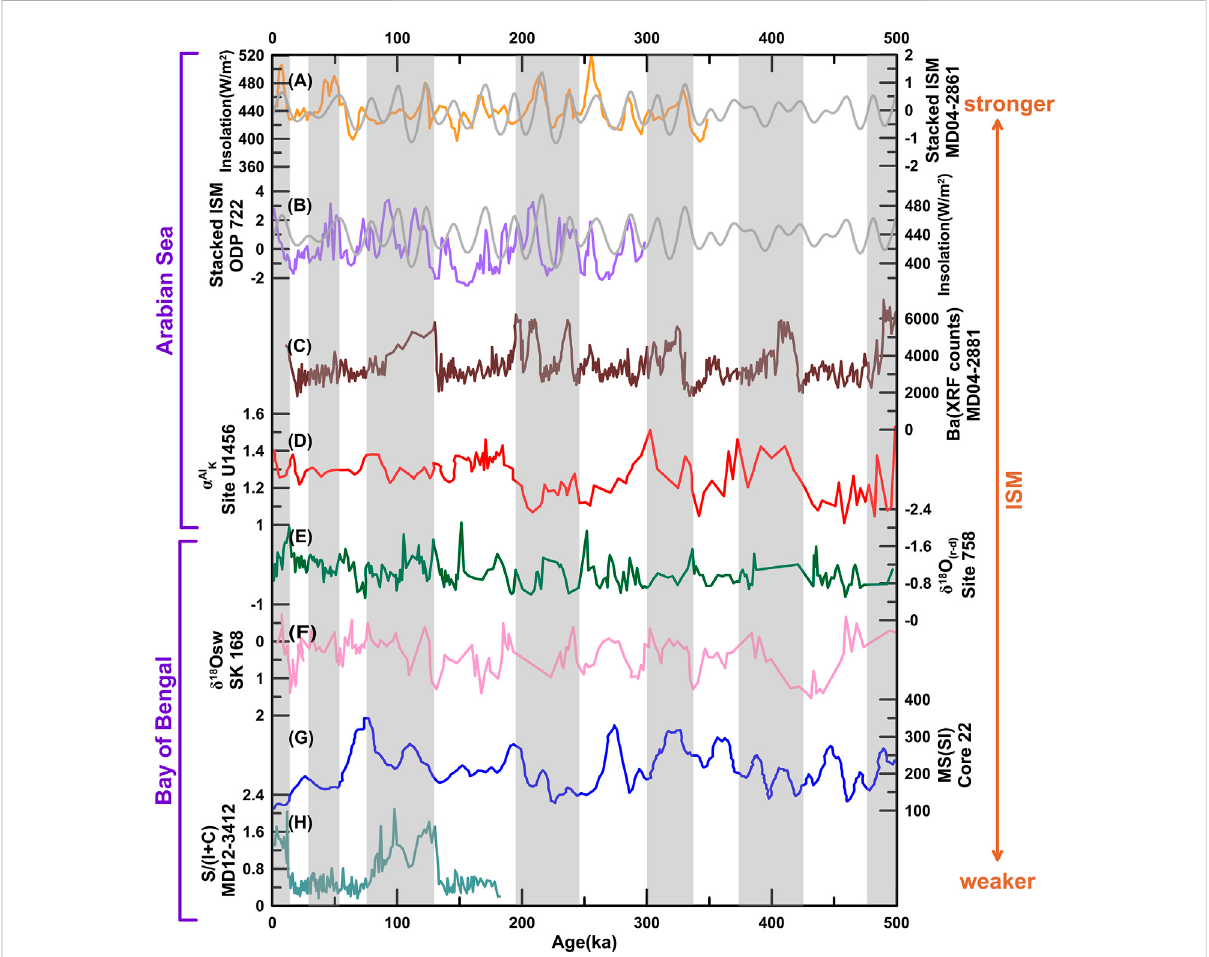
FIGURE 2 Comparison between the ISM records from marine sediments. (A) and (B) are the stacked ISM records from Arabian Sea cores MD04-2861 (Caley et al., 2011c) and ODP722 (Clemens and Prell, 2003), respectively. July 21 insolation at 65 ° N (grey) is plotted for comparison; (C) Ba counts recordofMD04-2881(Loulergueetal.,2008); (D) Variationsin α Al K atSiteU1456(Chenetal.,2020); (E) Site758 δ 18 O (r-d) record(Boltonetal.,2013); (F) Ice volume corrected δ 18 Osw of SK 168 (Gebregiorgis et al., 2016); (G) Core 22 variation in Magnetic Susceptibility (MS) (Weber et al., 2003);